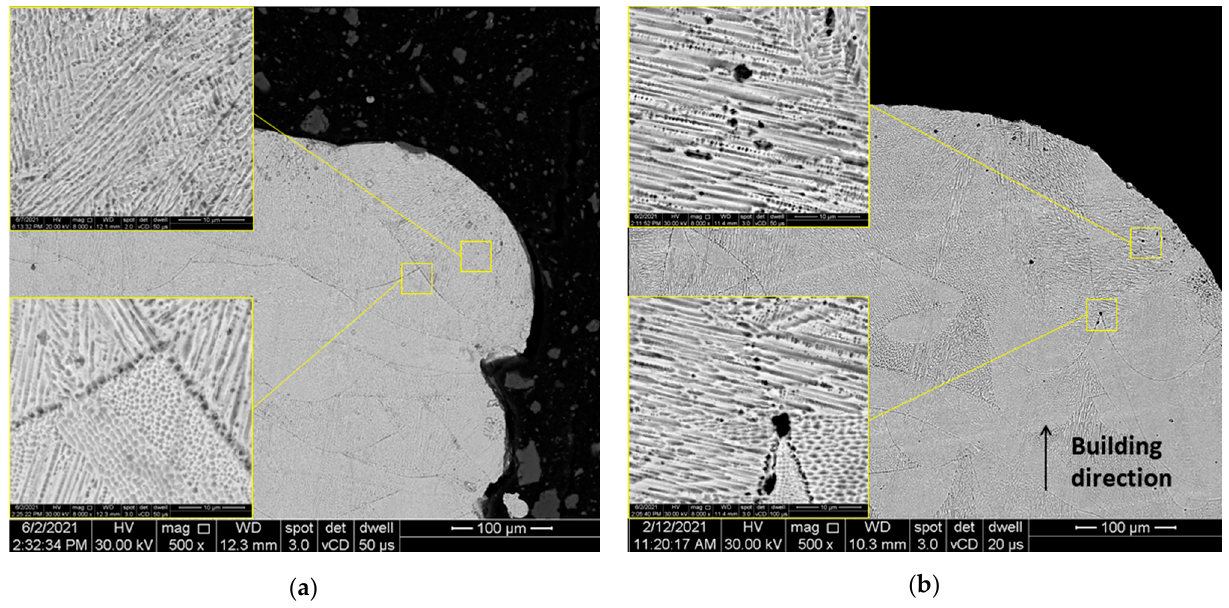
Figure 6. Porosity in SLMed IN 625: ( a ) with negative (conduction mode) and ( b ) positive (keyhole mode) defocusing distances.